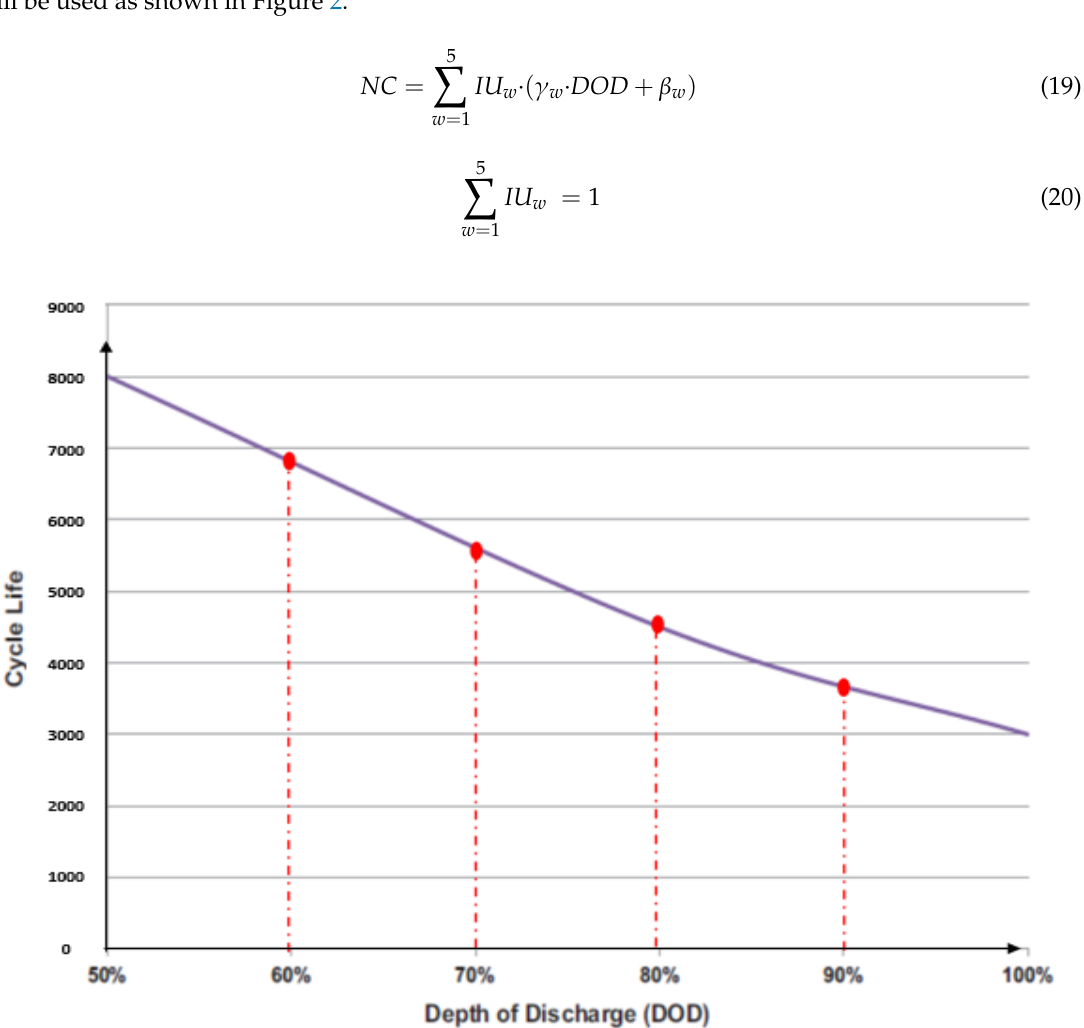
Figure 2. The linearized five segment curve between the battery depth of discharge (DOD) and cycle life (NC).